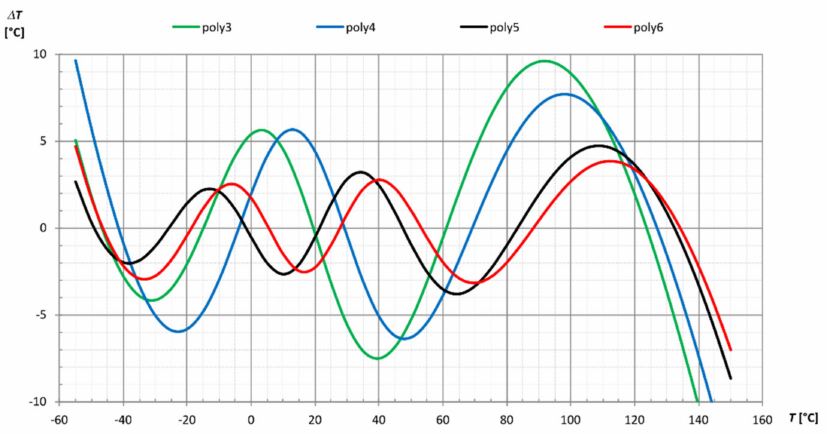
Figure 10. Temperature error for different polynomial order approximations—fitted across nominal temperature range.